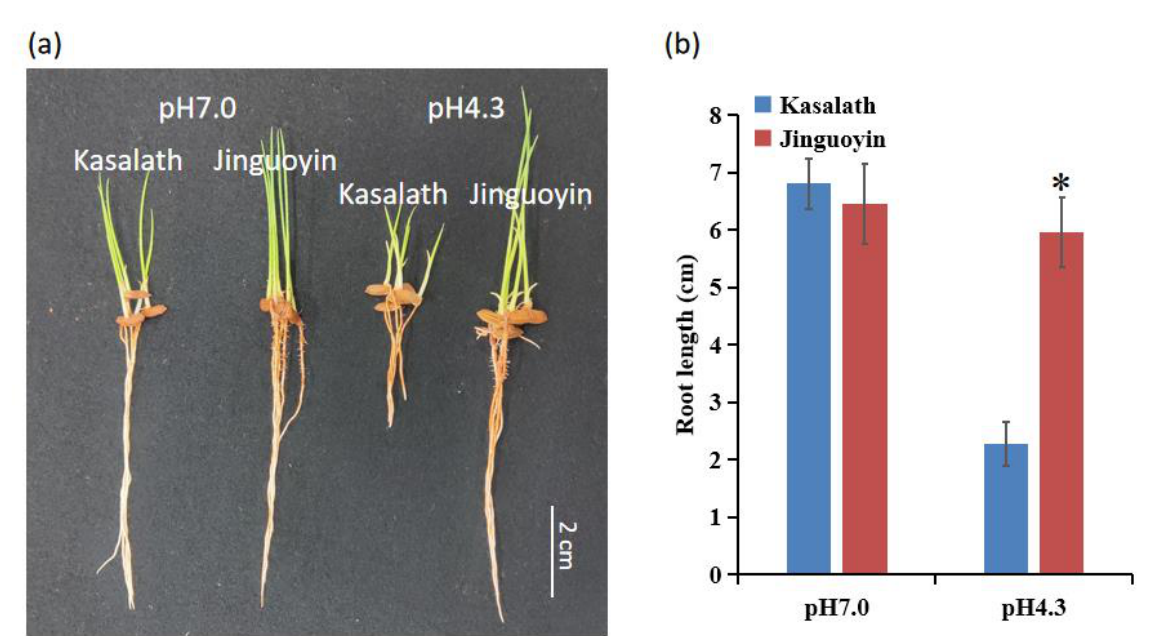
Figure 3. Root growth in acid and neutral soils. Root growth phenotype of two cultivars grown in acid and neutral soil ( a ); root length ( b ). Germinated seeds of Kasalath and Jinguoyin were sowed in acid soil with a pH of 4.3, or neutral soil with a pH of 7.0, and grown for 4 d. Neutral soil is modified from acid soil by amending it with CaCO 3 at 8.0 g (kg soil) − 1 . Data are mean ± SD (n = 5). Asterisks (*) indicate significant differences between Kasalath and Jinguoyin at p -values of <0.05 by the Student’s t -test.